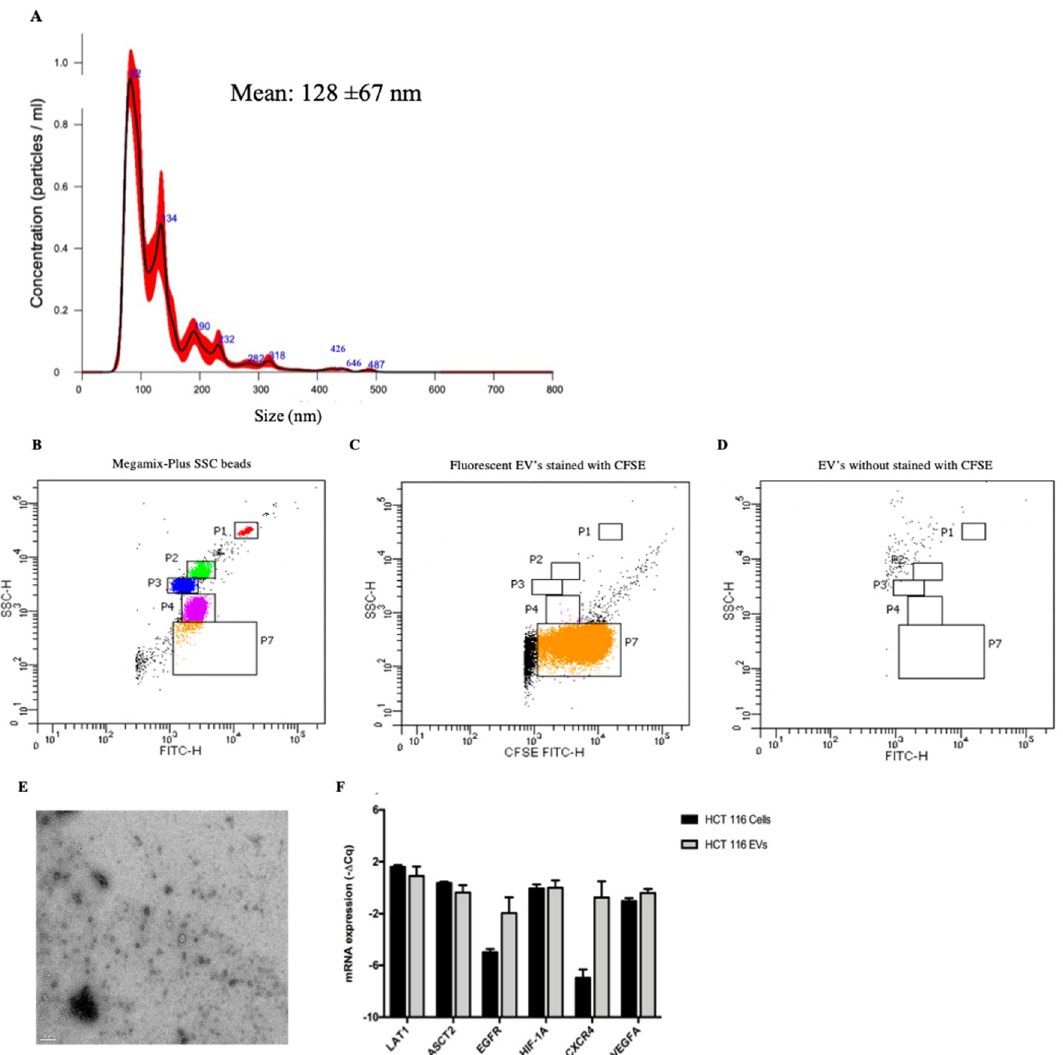
Figure 2. ( A ) NTA analysis of HCT 116-EVs showing the size distribution of EVs. ( B ) Megamix-Plus SSC beads used to define the cytometer settings for EVs’ acquisition, with the following diameters: 0.5 µ m (gate P1), 0.24 µ m (gate P2), 0.20 µ m (gate P3) and 0.16 µ m (gate P4); ( C ) Fluorescent EVs (approximately 2.6 × 10 5 /200 µ L) as observed by flow cytometry from a sample of EVs isolate derived from HCT 116 cell line stained with CFSE (gate P7); ( D ) Negative control of EVs isolate derived from HCT 116 cell line without previous staining (gate P7). ( E ) Transmission electron microscopy (TEM) of EVs derived from HCT 116 cell line (scale 200 nm). The TEM image was acquired in the Histology and Electron Microscopy platform from I3S Porto using a Transmission Electron Microscope Jeol JEM 1400. ( F ) The bars represent the – ∆ Cq of the mRNAs’ expression, normalized to B2M . The graph shows the presence of intracellular and EVs related mRNAs levels ( LAT1 , ASCT2 , EGFR , HIF1-A , CXCR4 and VEGFA) derived from HCT 116 cell line. (Mean ± Std.